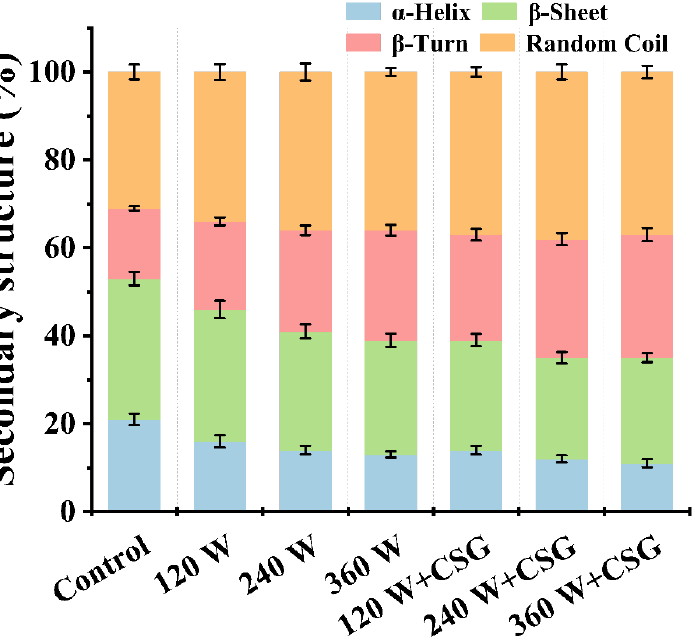
Figure 5. Protein secondary structures of WPI and WPI–CSG systems treated by different power